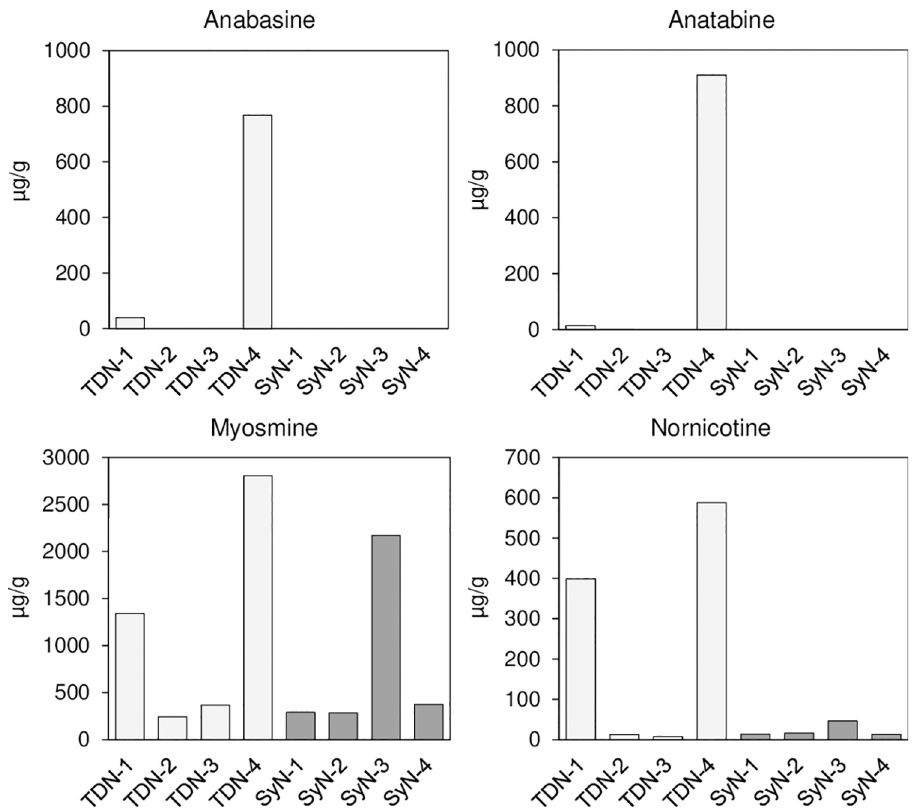
Fig 3. Analysis of select nicotine degradants in tobacco-derived and synthetic nicotine